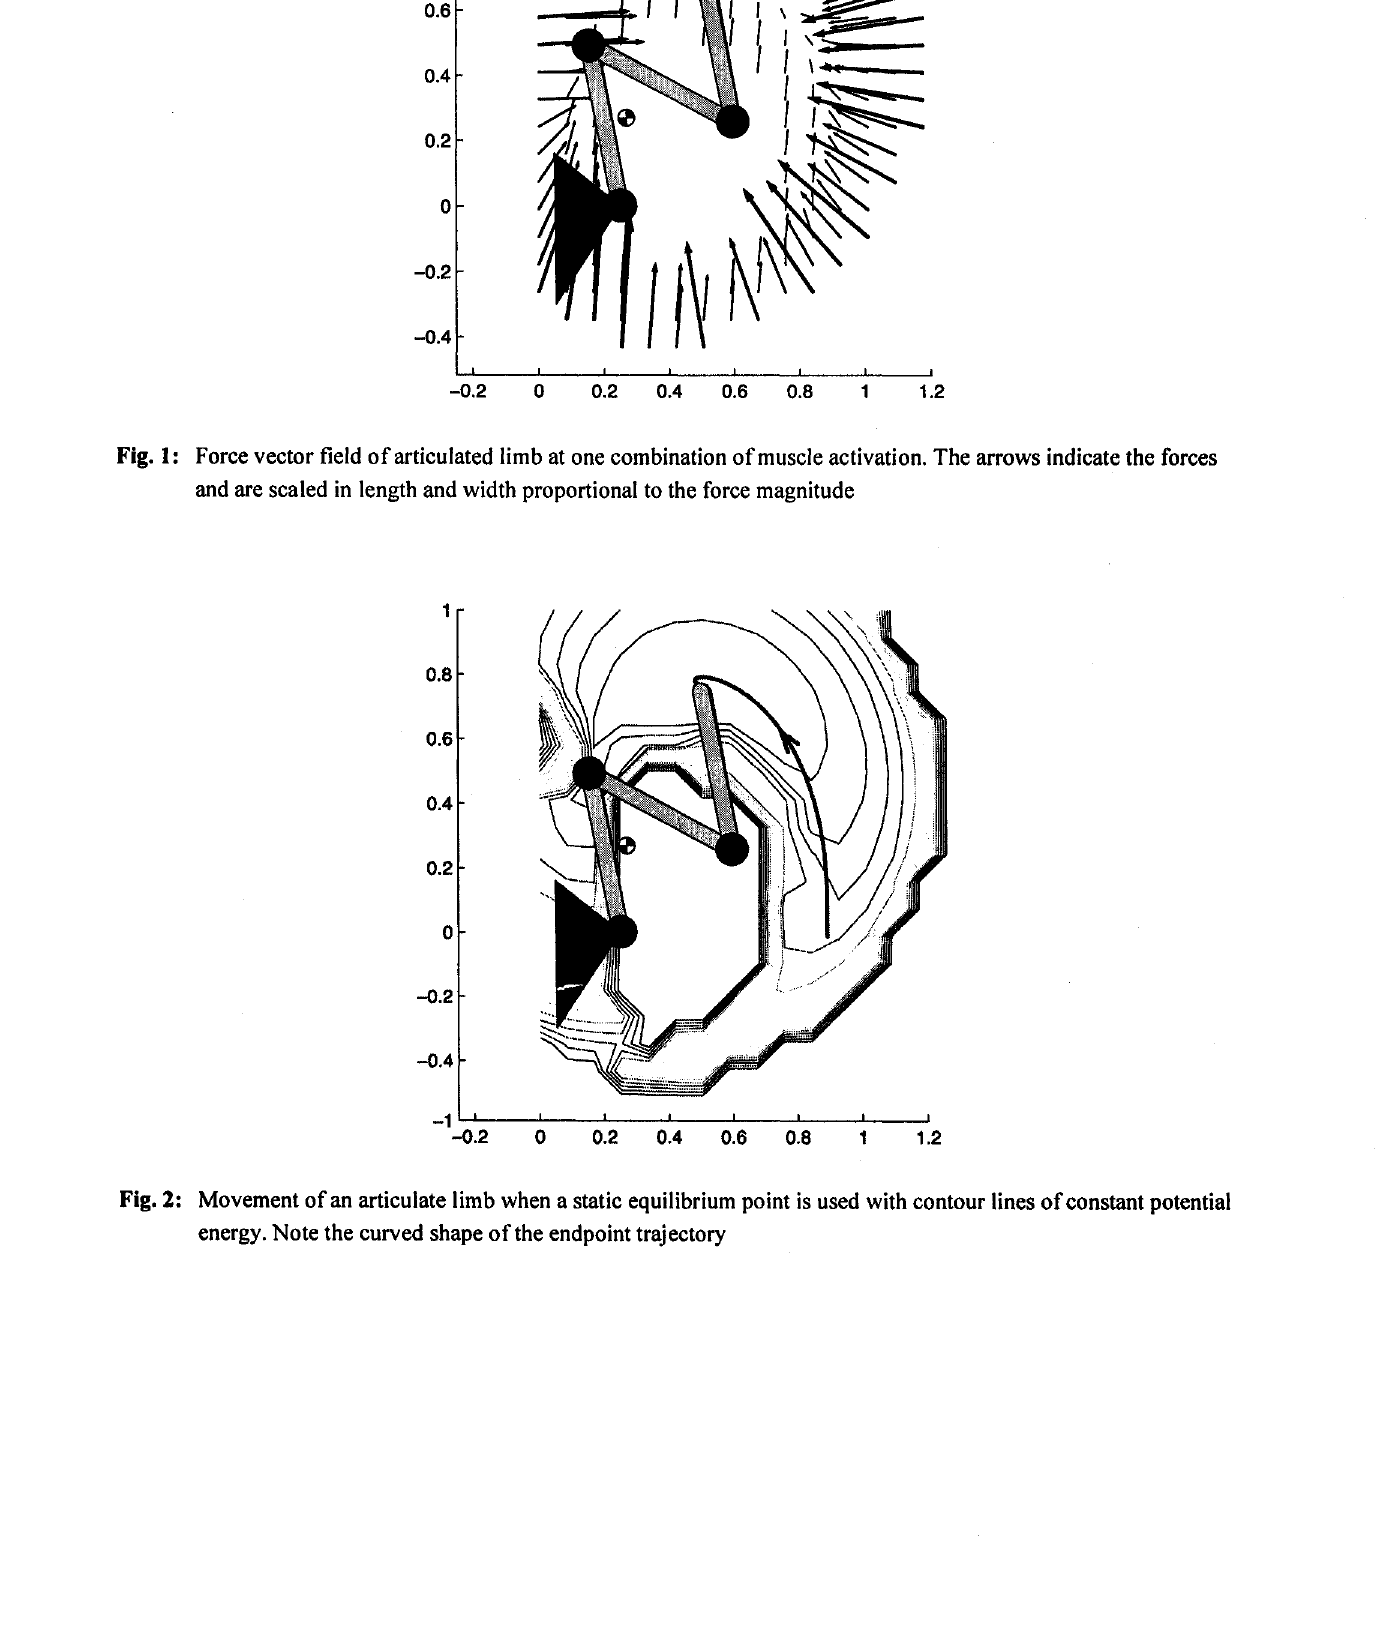
Fig. 1" Force vector field of articulated limb at one combination of muscle activation. The arrows indicate the forces and are scaled in length and width proportional to the force magnitude